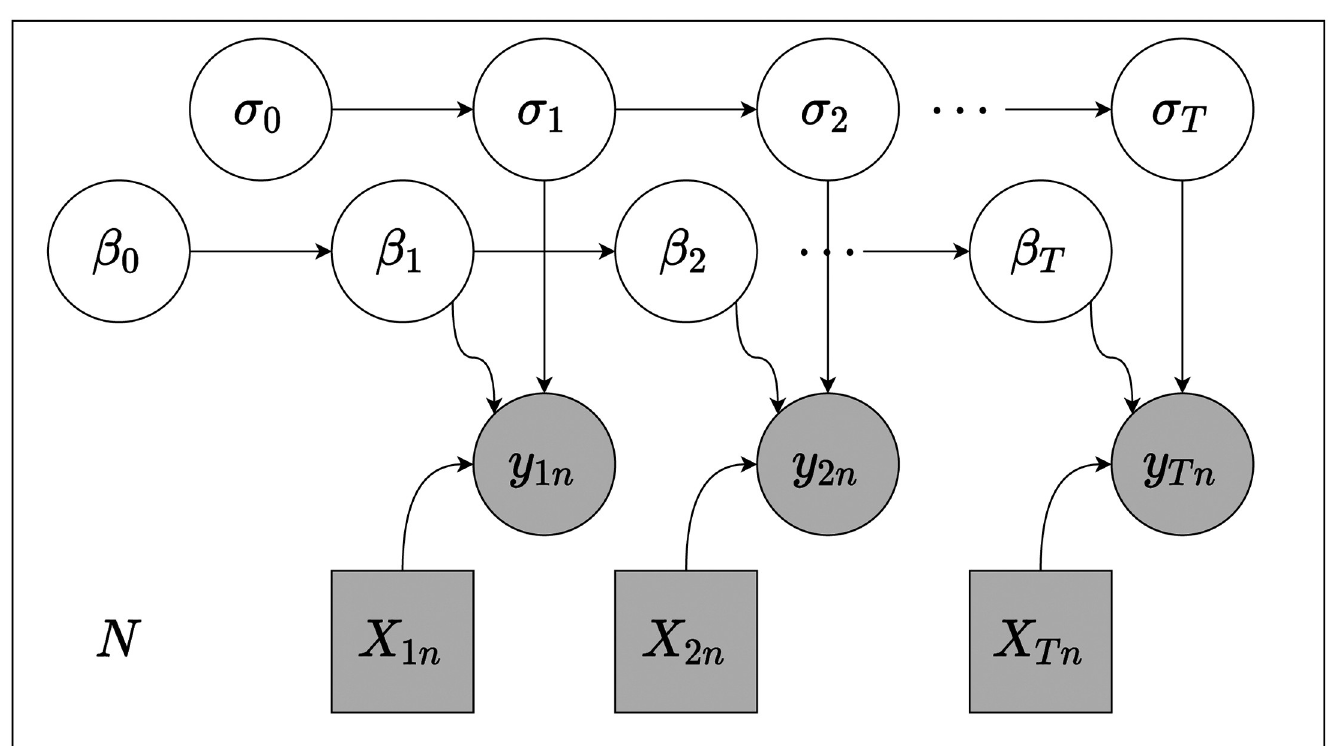
are treated as tn